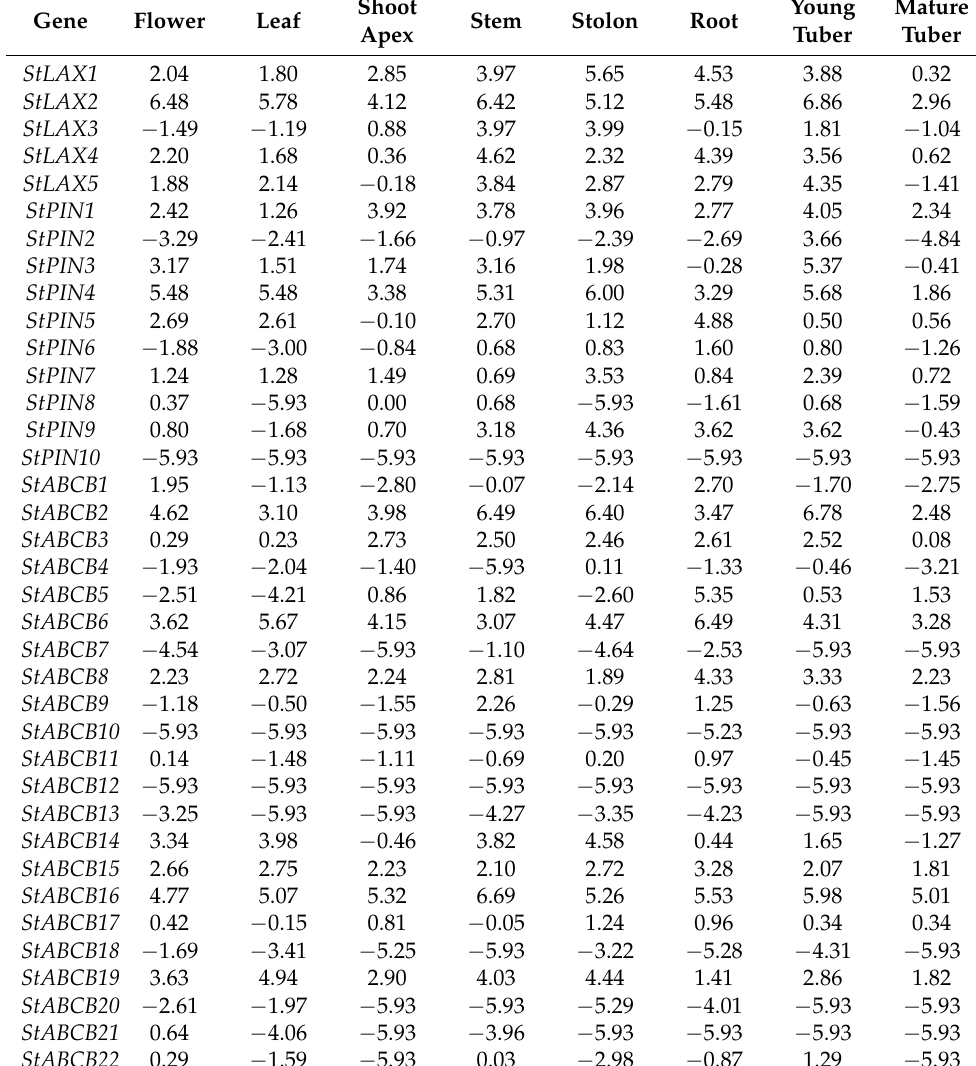
Table A7. Fragments per kilobase per million (FPKM) values of auxin transporter genes in various tissues. Gene